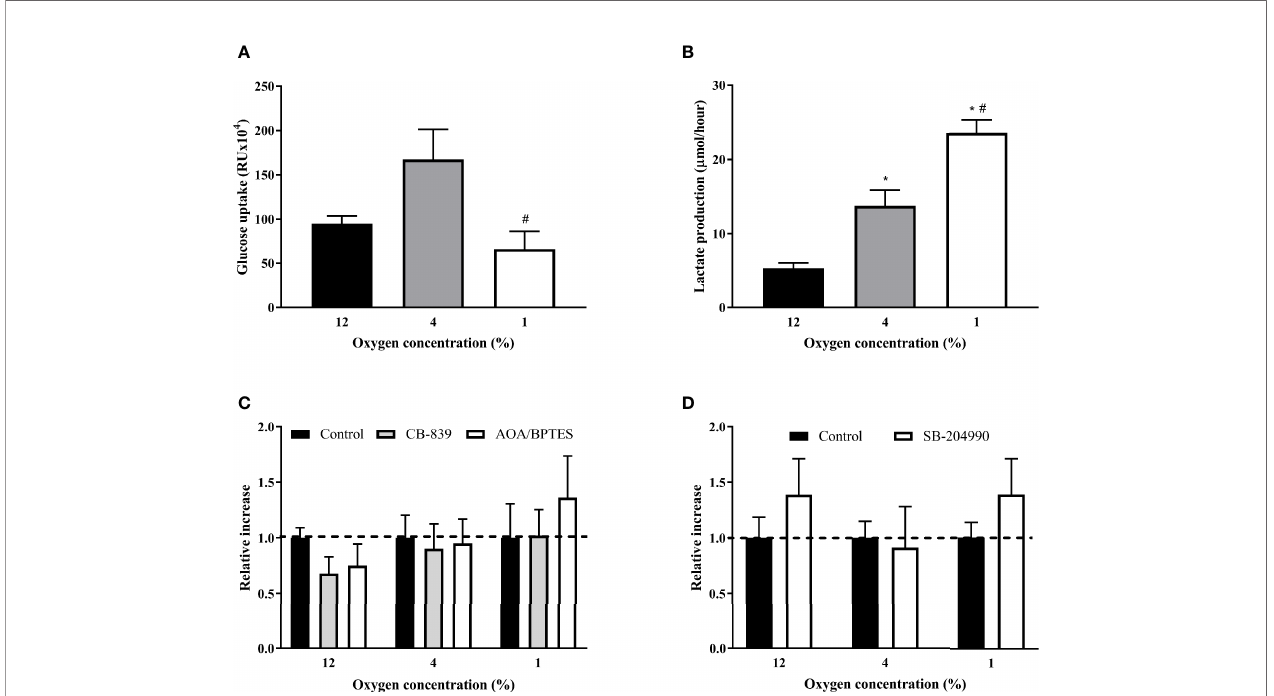
FIGURE 4 | The Effect of Hypoxia and rTCA Inhibitors on Glucose Uptake and Lactate Production. The effect of hypoxia (A) , glutamine mitochondrial transport inhibitors (C) and ATP-dependent citrate lyase inhibition (D) on glucose uptake or lactate production (B) . (A, B) Glucose uptake and 24-h lactate production was measured after exposure to hypoxia for 7 days. Differentiated L6 myotubes were exposed to hypoxia for 7 days and subsequently treated with 500 nM CB-839, 1 mM AOA, 2 m M BPTES (C) or 40 m M SB-204990 (D) for 24 hours. *p < 0.05 for comparison with control exposures (ANOVA for A , B or 2-way ANOVA for C, D , N = 6); # p < 0.05 for comparsion with 4% O 2 exposures (ANOVA, N = 6).